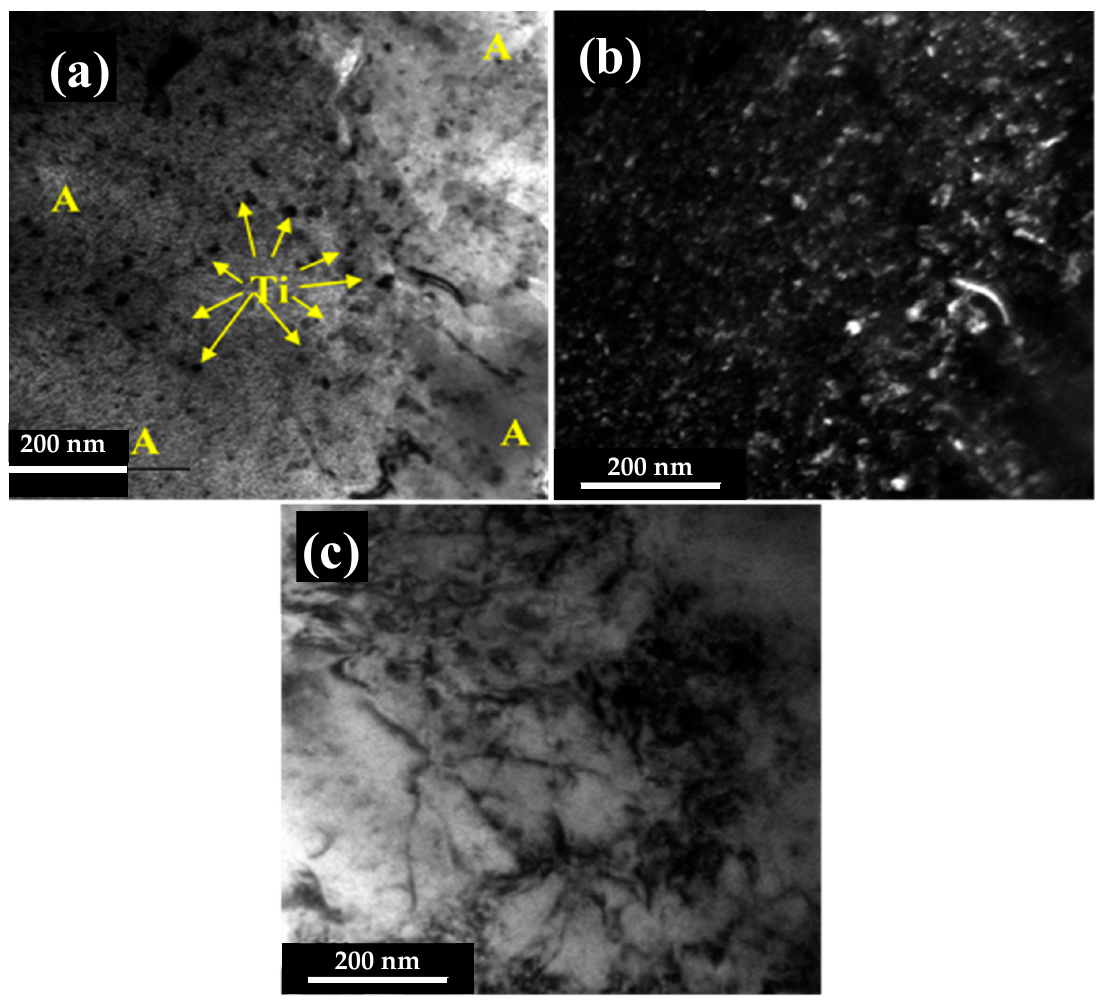
Figure 6. HR-TEM micrograph of Al–12 wt.% TiC nanocomposite: uniform distribution of TiC nanoparticles: ( a ) BFI, ( b ) DFI and ( c ) dislocations.